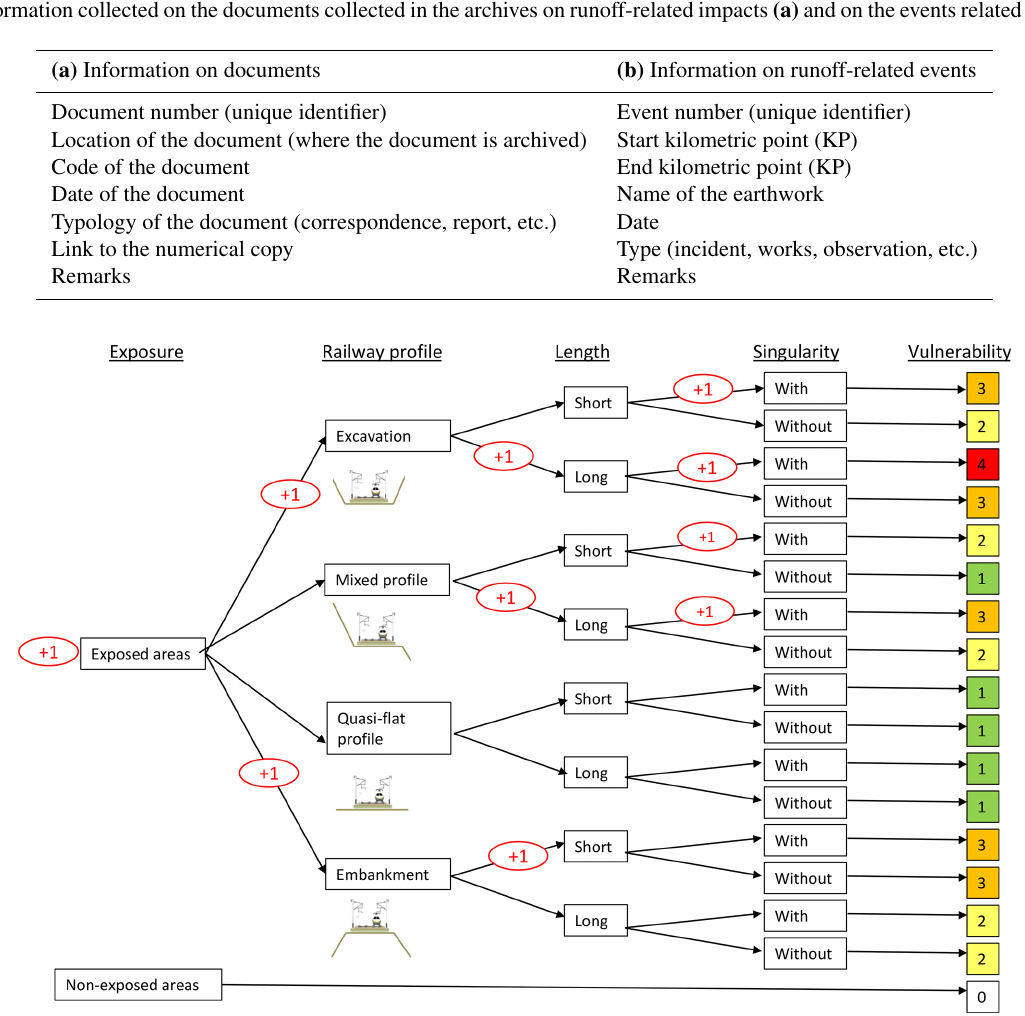
Figure 5. Vulnerability tree of the railway sections (also called earthworks) based on expert judgement. Each column corresponds to one criterion considered when computing the vulnerability of the section: the exposure (non-exposed sections are long tunnels or viaducts; column 1), the type of railway profile (column 2), the length of the section (column 3) and the existence of a singularity (level crossings, road bridges, or tunnel inlets or outlets; column 4). The + 1 in the red circles indicates that 1 is added to the vulnerability score of the section to provide the final score that appears in the last column of the